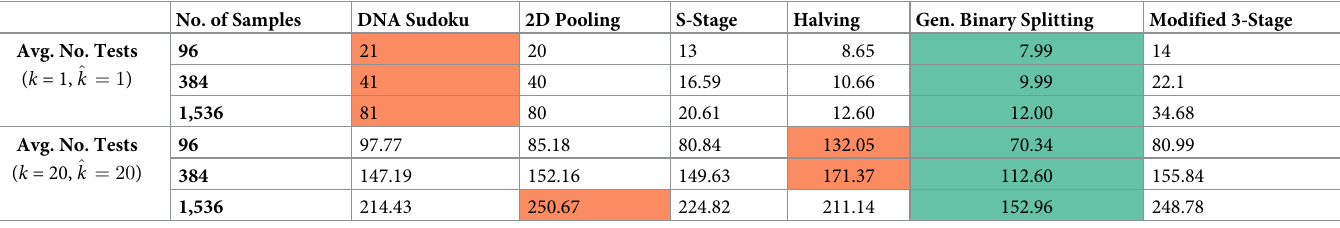
Table 2. Average number of tests for each of the pooling methods for sample sizes N = 96, 384, and 1,536, when k = 1 and k = 20. No. of Samples DNA Sudoku 2D